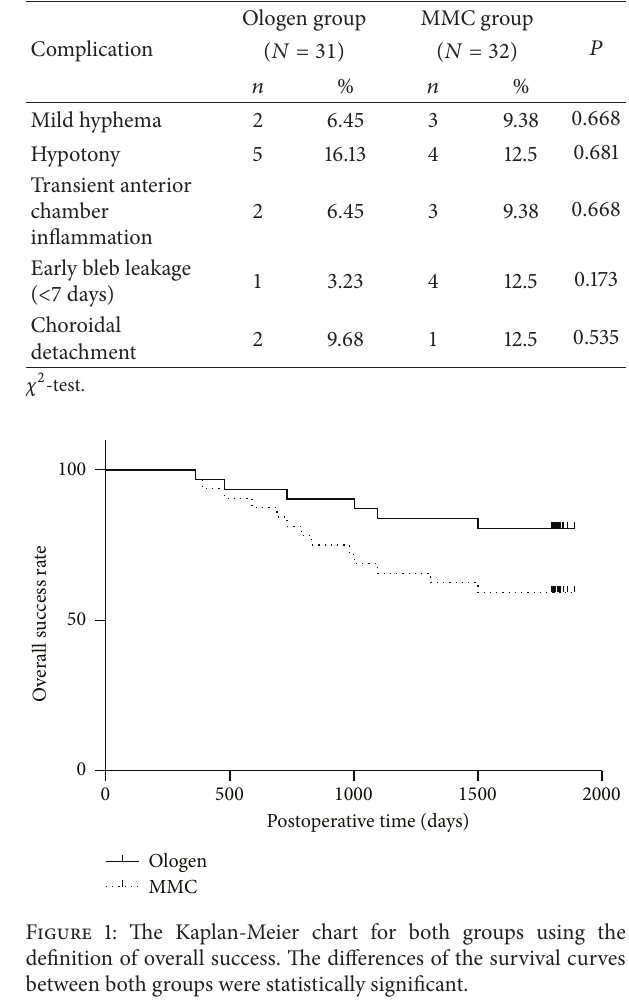
Table 3: The success rate comparison between the Ologen and MMC groups.